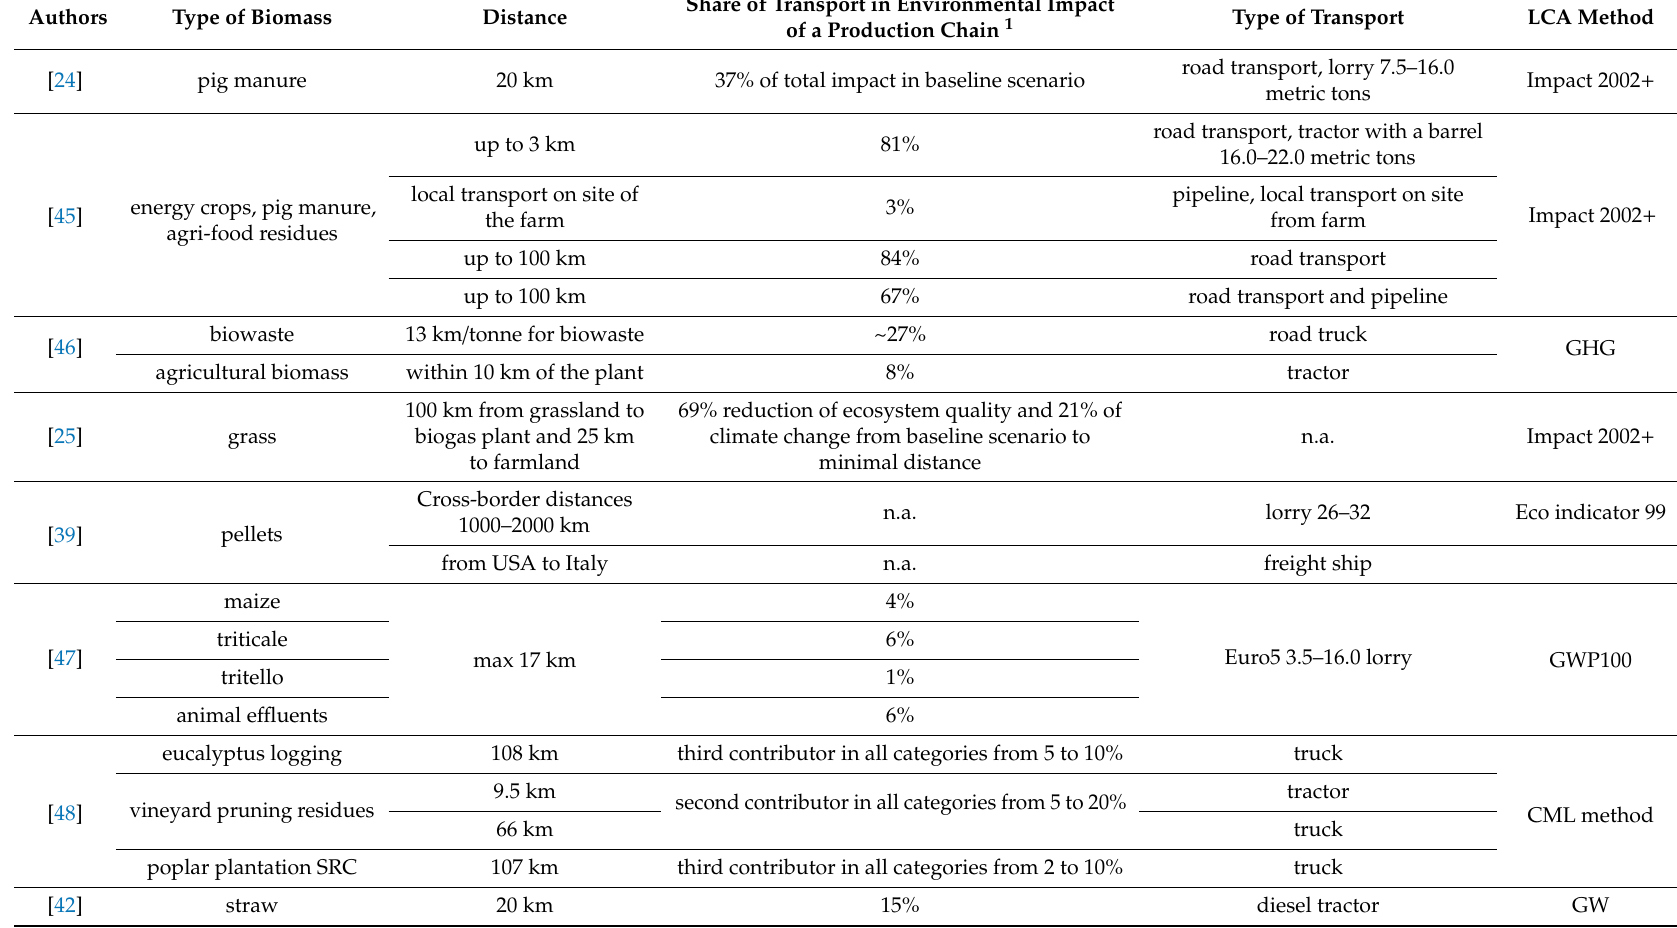
Table 3. Environmental studies concerning the share of transport in the environmental impact of a system boundary